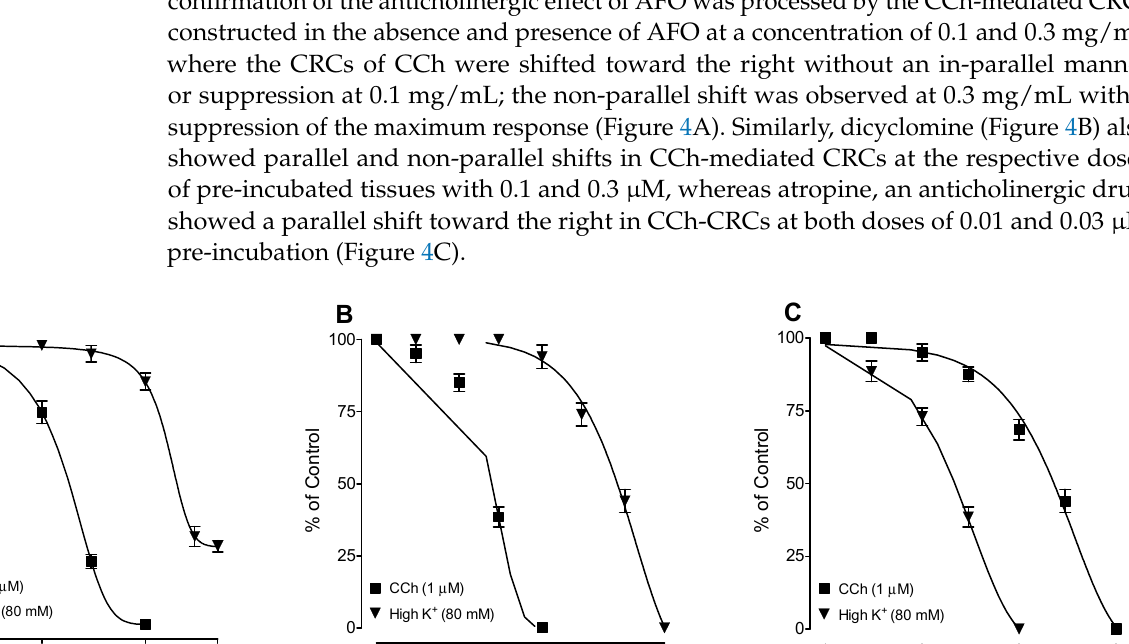
and ( C ) verapamil against carbachol (CCh; 1 µM) and high K + (80 mM)-induced contraction in